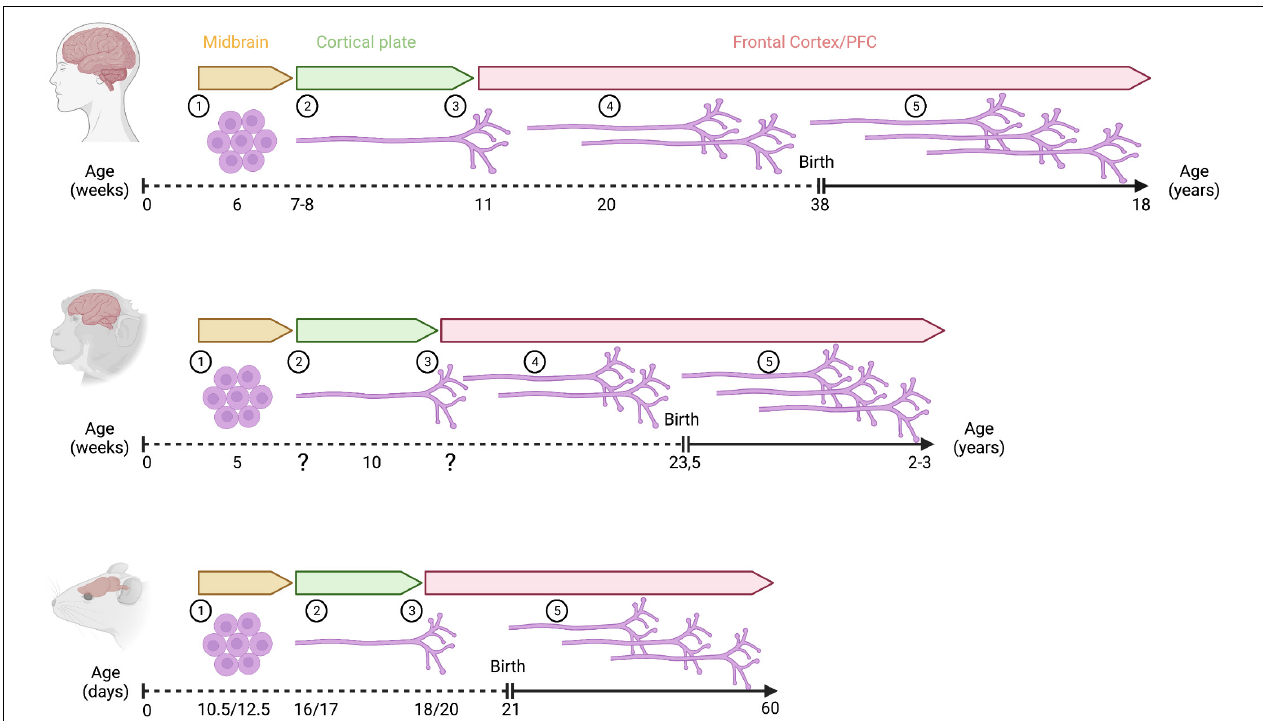
FIGURE 2 | Development of mesoprefrontal DA projections in primates and rodents. Critical developmental stages of the mesoprefrontal DA system are shown as follows: (1) onset of differentiation of dopaminergic neurons, (2) dopaminergic axons reach the cortical region, but do not yet enter into the developing cortical plate (3) dopaminergic axons innervate the cortical plate, (4) density of innervation increases during embryonic development (indicated by multiple axons), (5) density of innervation increases further during postnatal development (indicated by multiple axons). Note that the increase in innervation density occurs essentially only during the postnatal period in rodents. In primates, the timeline of prenatal development is shown in weeks, and the postnatal period is shown in years. In rodents, prenatal and postnatal stages are indicated in days (mouse/rat). Created with